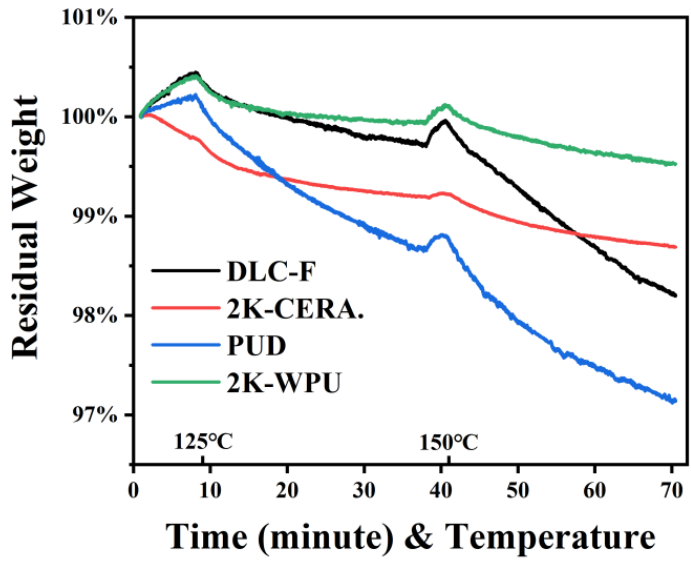
Figure 6. TGA analysis of PUD/DLC-F/2K-WPU/2K-CERA. film. The adhesion property of the coatings to the substrates was evaluated using the ISO 2409/ASTM D3359 tape test with cross-cuts. The adhesion property is marked by the fraction of detachment of the coating. Typically, the film thickness should be less than 60 µ m, and the cross-cutting spacing was set to 1 mm, using adhesive tape to stick the cutting parts several times after cross-cutting. The results were evaluated via naked- eye observations and classified according to a standard scale (class 0 is the best with no detachment, class 5 is the worst with more than 65% detachment for ISO 2409, class 5B is the best with no detachment, class 0B is the worst with more than 65% detachment for ASTM D3359). The typical adhesion results are presented in Figure 7.